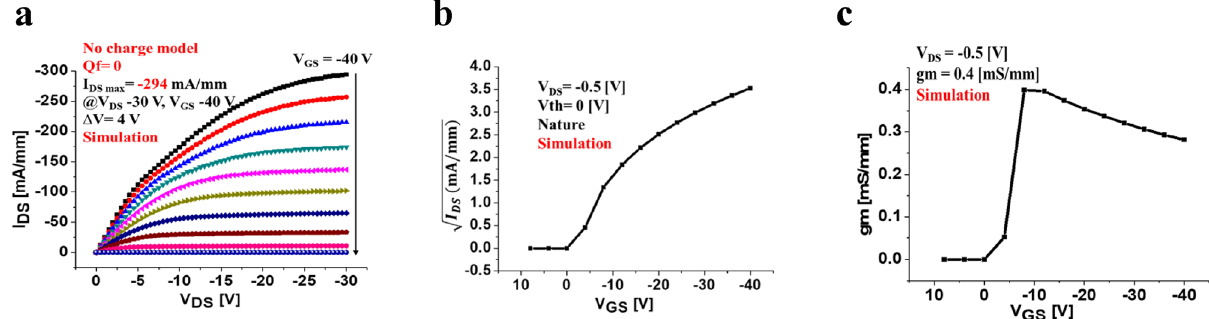
Figure 6. The simulated I DS –V DS characteristics of 2DHG diamond MOSFET in the neutral surface charge model (non-charged). (a) The maximum drain current density is I DSMax = − 294 mA/mm with V DS of 30 V, and V G ranges from − 40 V to 8 V with a voltage step of 4 V. (b) Threshold voltage simulated at V th = 0 V indicating no operation of the device at V DS = − 0.5 V. (c) The transconductance of device g m = 0.4